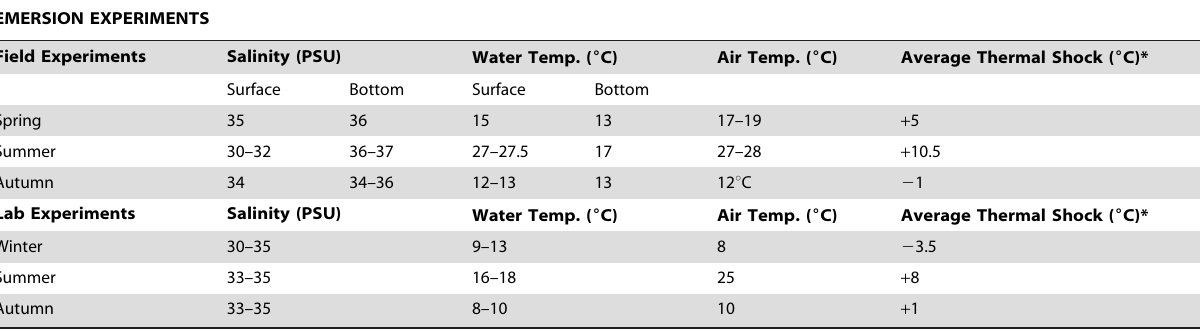
Table 1. Environmental parameters recorded in the field and lab